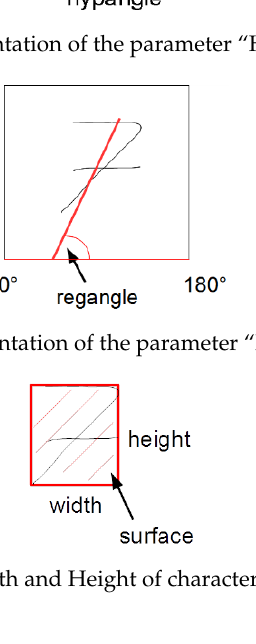
Figure 8. Width and Height of character sequence.